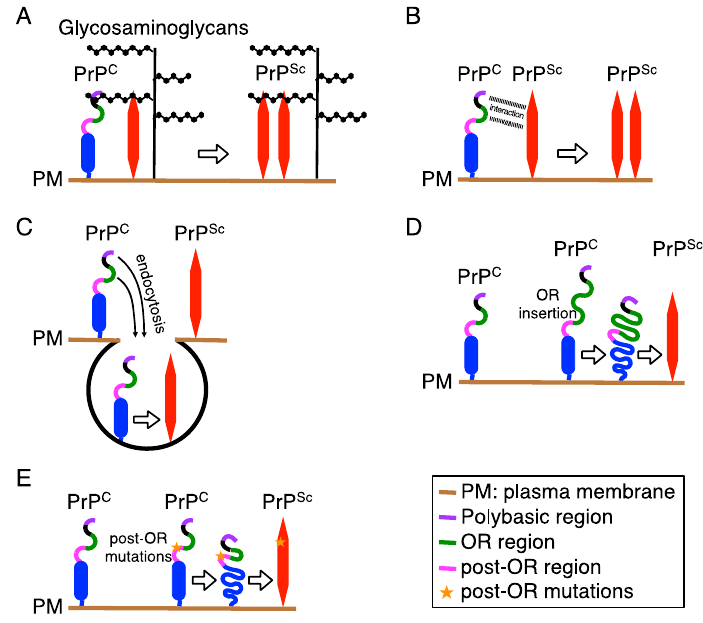
Figure 2. Possible roles of the N-terminal regions in the conversion of PrP C into PrP Sc . Upon conversion of PrP C into PrP Sc , PrP C might interact with PrP Sc through glycosaminoglycans ( A ) or through the polybasic and OR regions ( B ). ( C ) The polybasic and OR regions are also involved in endocytosis of PrP C to endosomal compartments, where PrP C is considered to convert into PrP Sc . Extra OR sequences in the OR region ( D ) and point mutations in the post-OR region ( E ) might render mutated PrPs structurally unstable, ultimately leading to their spontaneous conversion to pathogenic